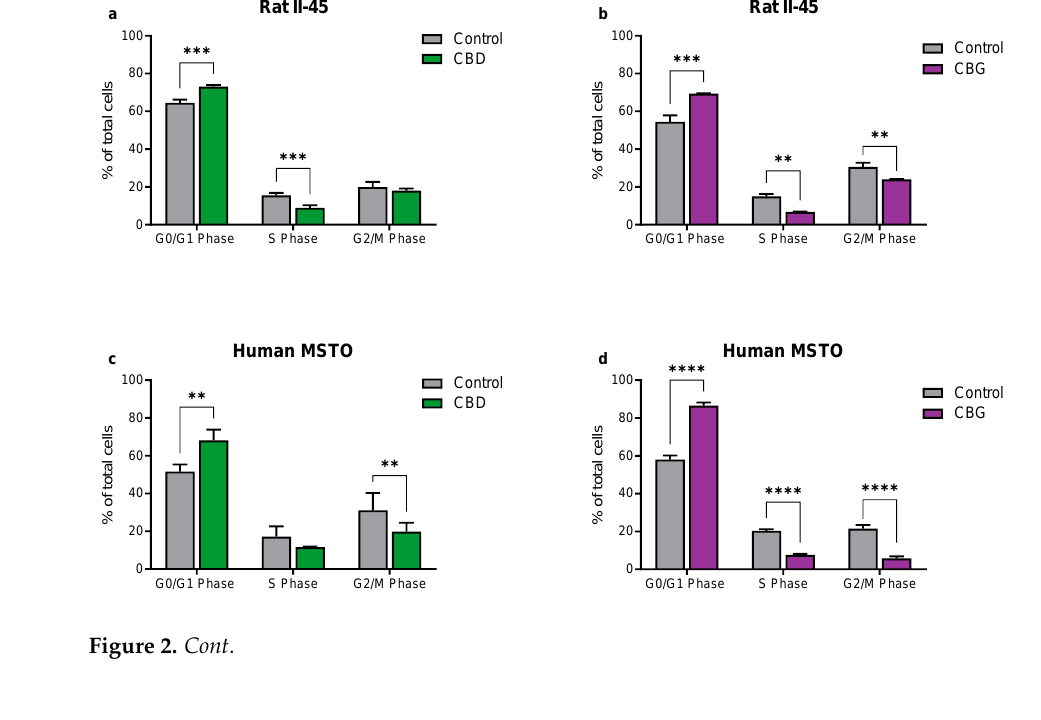
Figure 2. The phytocannabinoids cannabidiol (CBD) and cannabigerol (CBG) induce cell cycle arrest in mesothelioma cell lines. The effects of CBD and CBG (2xIC50) on cell cycle were assessed in rat II-45 ( a , b ), human MSTO ( c , d ) and H2452 ( e , f ) mesothelioma cell lines. After 24 h of treatment with vehicle (control), CBD or CBG, cells were harvested, and assays performed. Bars show the mean and SD from three independent experiments. p -values were calculated using two-way ANOVA Holm-Sidak ’s multiple comparisons. ** p < 0.01, *** p < 0.001, and **** p < 0.0001 relative to vehicle-treated control cells.